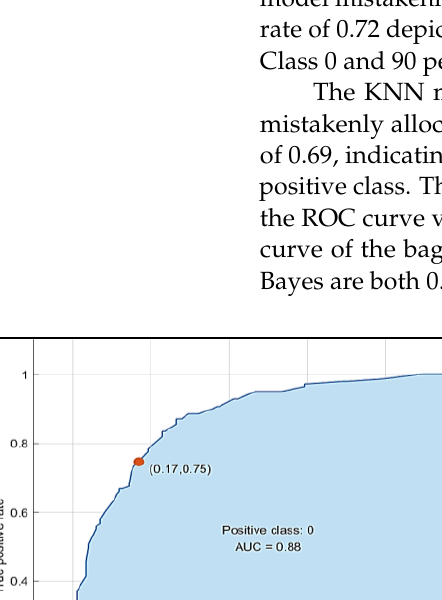
Figure 11. ( a ) ROC curve corresponding to class 0 using the KNN ( b ) ROC curve corresponding to class 1 using the KNN.